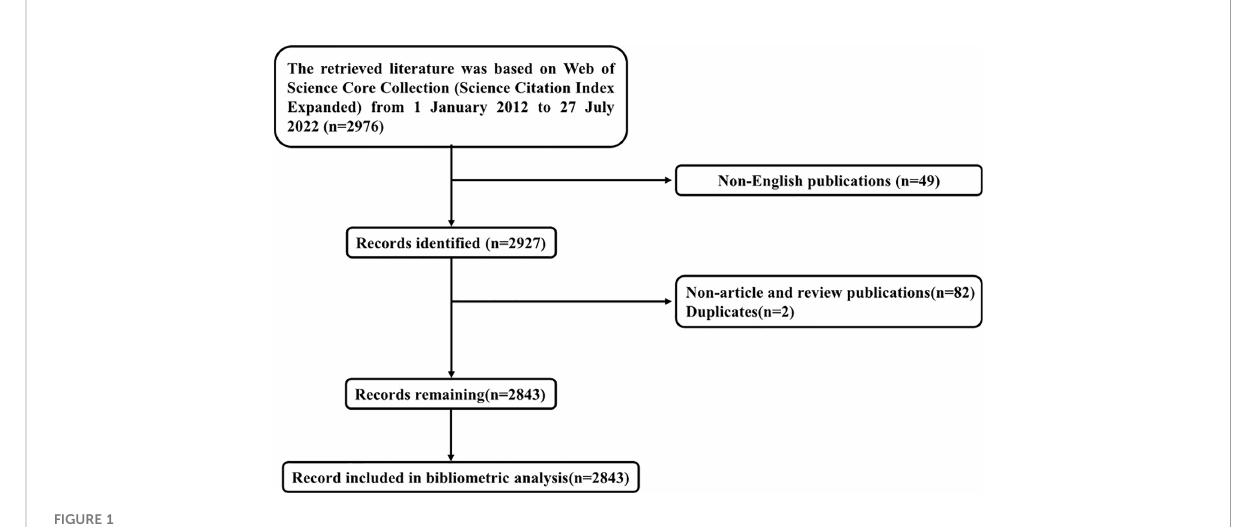
FIGURE 1 Flow chart of document selection and identi fi